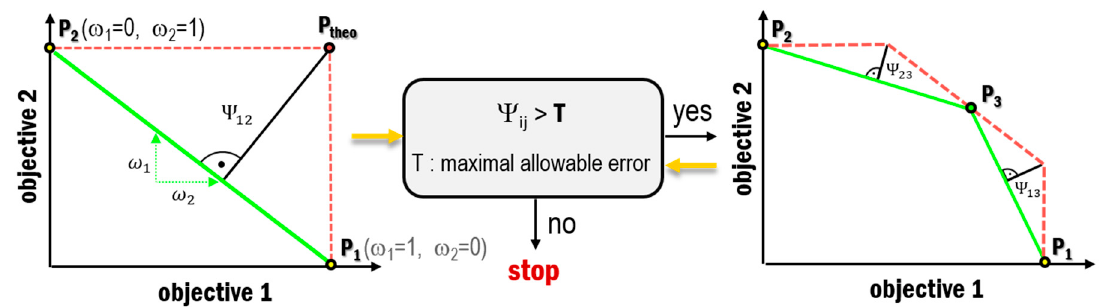
Figure 2. The NISE approach, where solutions are iteratively added to the Pareto set until a maximum allowable error is no longer violated. The weight combinations for new solutions result from the slopes when the points of the current pareto set are connected.